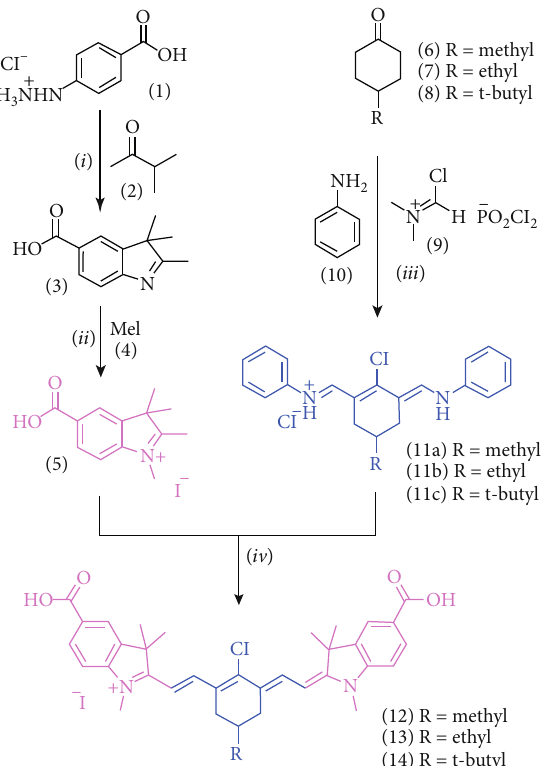
Scheme 1: Synthesis of heptamethine cyanines 12-14, where (i) COOH/re fl ux; (ii) CH CH 3 aniline/EtOH, 0 ° C; (iv) dark, N